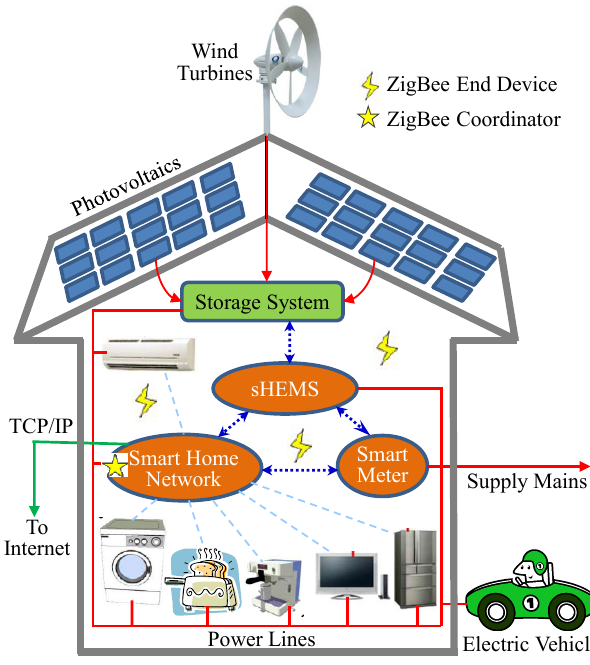
Figure 1. Architecture of the smart microgrid